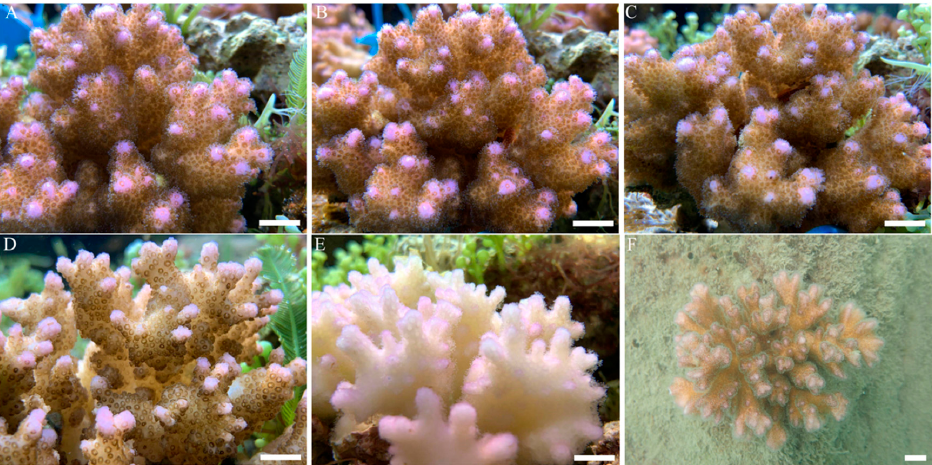
Figure 2. Morphological changes on the surface of one coral nubbin representative in response to increased temperature stress in an aquarium. The temperatures from ( A – E ) are 26 °C (control), 30 °C, 32 °C, 34 °C, and 26 °C (recovery), respectively; ( F ) shows the morphology of coral in a natural sea. (Scale bar, 1 cm).